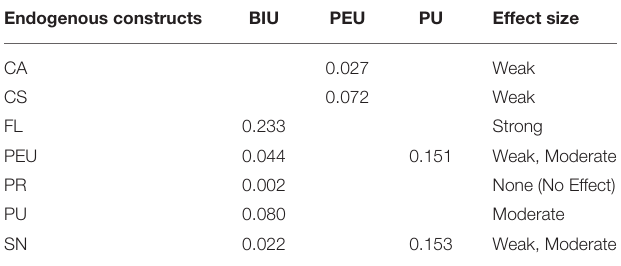
TABLE 14 | Mediation assessments of perceived usefulness (PU).